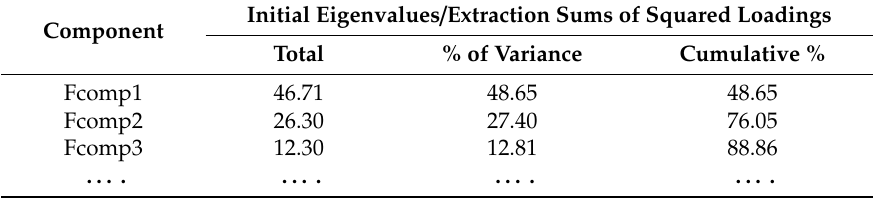
Table 2. Results of principal component analysis of sediment grain-size of core